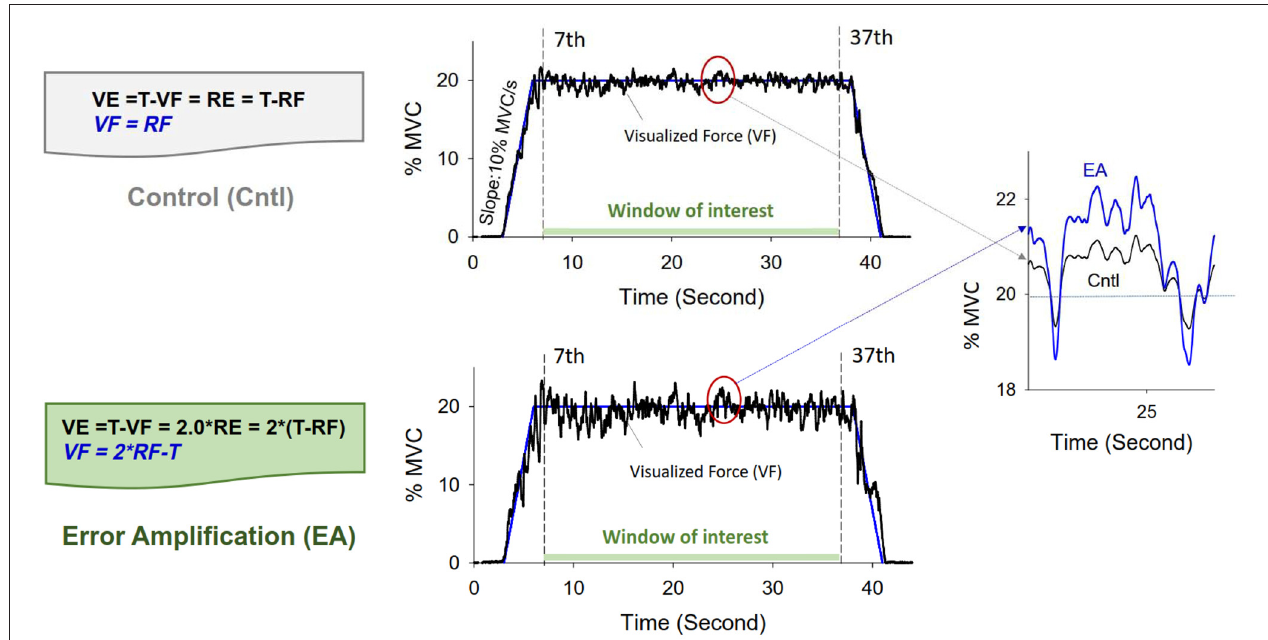
FIGURE 1 | Illustration of modulation of error augmentation feedback. With mathematical transformation, the VF outputs in the error amplification (EA) condition virtually double the size of the real execution error displayed in the control condition. In the control condition, the participant was provided with real error (VE = RE), as the VF output was identical to RF output. In the EA condition, the force output displayed on the monitor (VF) was transformed with VF = 2 ∗ RF − T. The size of the perceived tracking error was augmented by two times in the EA condition (VE = T − VF = T − (2 ∗ RF − T) = 2 ∗ (T − RF) = 2 ∗ RE). For a given experimental trial, the rightest plot displays VF at about 25th second in the control (black line) and EA (blue line) conditions. VF, visualized force; VE, visualized error; RF, real force; RE, real error; T, target